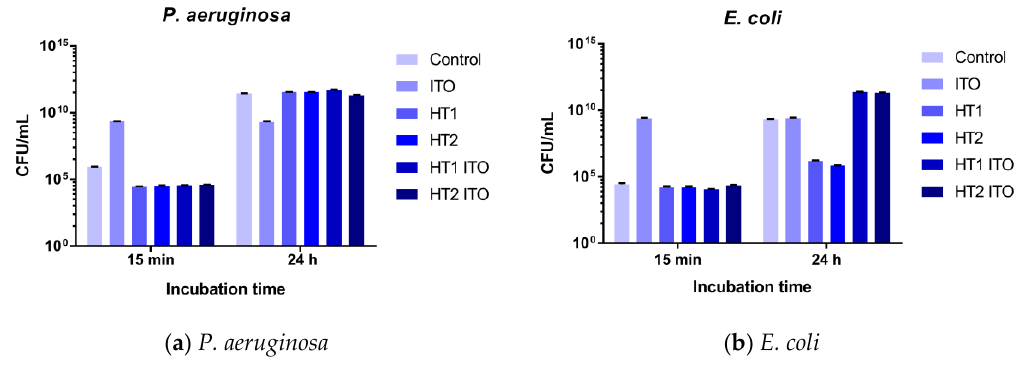
Figure 5. Graphic representation of CFU/mL of P. aeruginosa ( a ) and E. coli ( b ) viable cell counts recovered after 15 min and 24 h of contact with the photocatalyst-treated polyester fabrics.